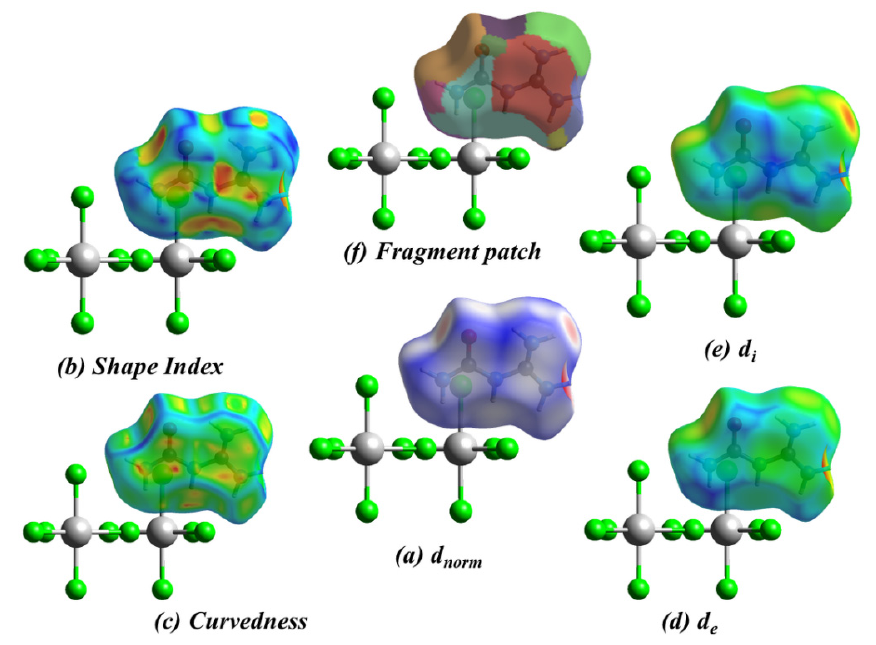
Figure 3 . 3D Hirshfeld surfaces of (C 2 H 7 N 4 O) 2 BiCl 5 mapped with d norm , shape index, curvedness, d e , d i , and fragment patch; ( a ) d norm ; ( b ) shape index; ( c ) curvedness; ( d ) d e , ( e ) d i , ( f ) fragment patch.